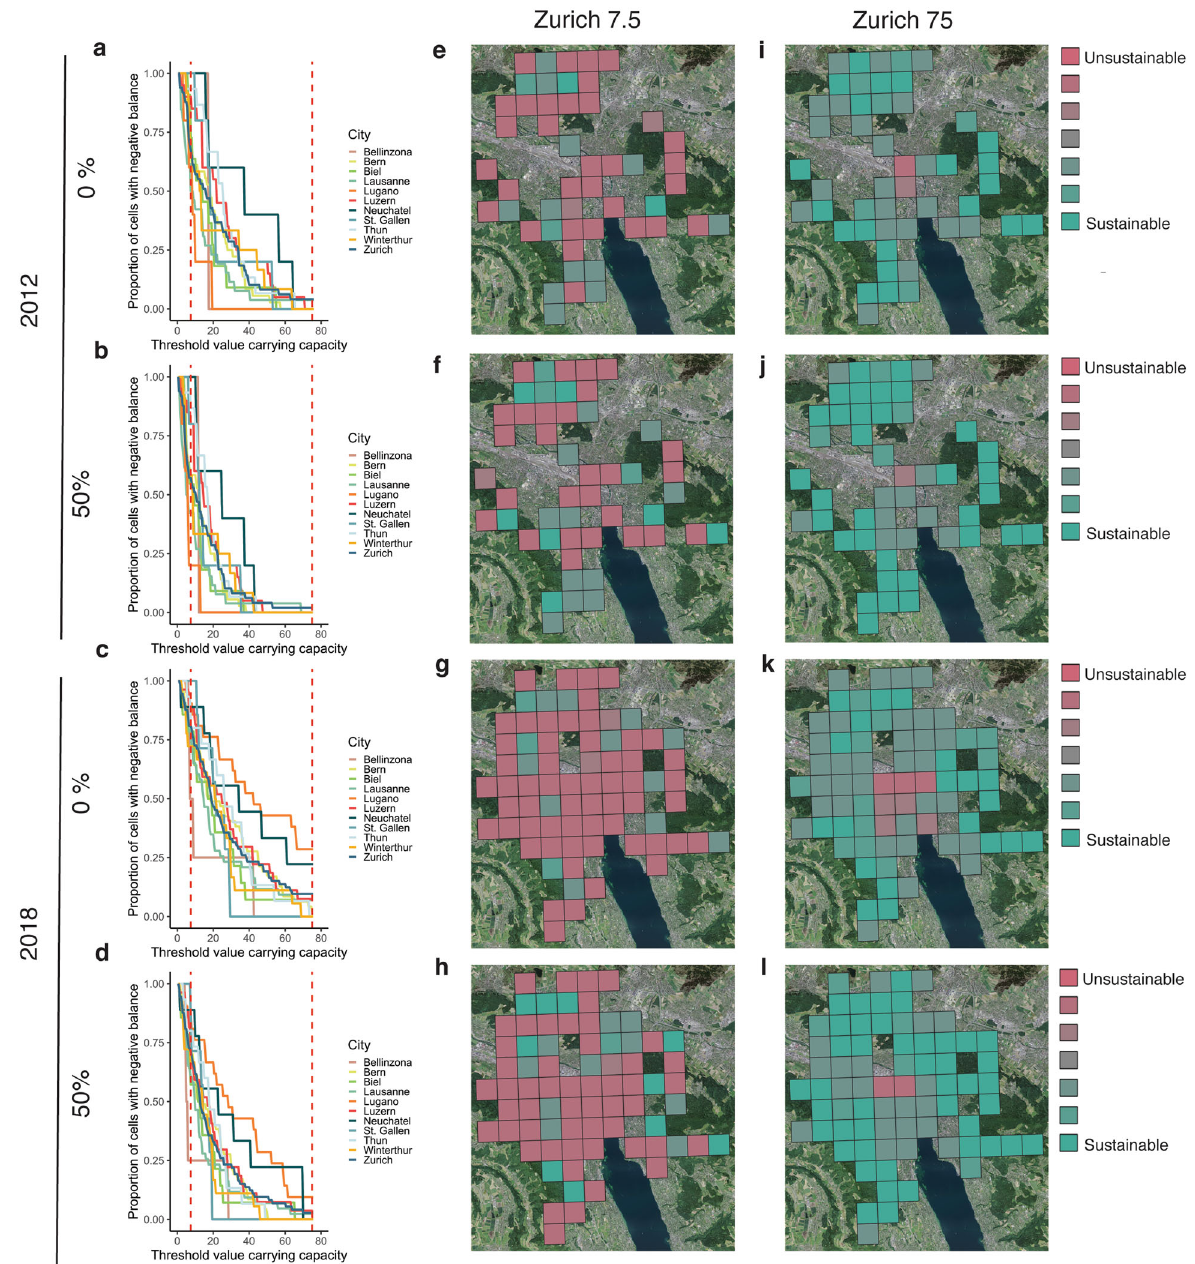
Fig. 2 Sustainability of urban beekeeping under different scenarios regarding the amount of available urban green space (UGS) and the carrying capacity for the years 2012 and 2018. a – d The proportion of cells with a negative UGS balance (Y-axis) (i.e. the available UGS is smaller than the required UGS based on the existing number of hives in the cell) for different carrying capacity values ( X -axis) for all cities in 2012 ( a and b ) and 2018 ( c and d ), and considering a 0% ( a and c ) or 50% ( b and d ) increase in available UGS. Each coloured line represents the model for one city. Dashed red vertical lines indicate the carrying capacities used in the plots ( e – l ) and represent 7.5 and 75 hives per 1 km 2 . e – l An example of the spatial distribution of the UGS balance in the cells in the city of Zurich for 2012 ( e , f , i , j ) and 2018 ( g , h , k , l ) considering an increase in both available UGS, from 0% ( e , g , i , k ) to 100% ( f , h , j , l ), and carrying capacity, from 7.5 ( e – h ) to 75 ( i – l ) hives per km 2 . See Supplementary Figs. 3 and 4 for additional scenarios, Supplementary Fig. 5 for the maps for all cities and Supplementary Fig. 6 for additional information on the balances in the UGS. Data supporting this fi gure can be found in Supplementary Data 2. Orthophotos from Zurich were obtained from the SWISSIMAGE 25 from the Federal Of fi ce of Topography Swisstopo openly accessible 30 Adding hives in new and existing beekeeping locations might result in strong pressure on available resources. In agricultural beehives was found to be negatively related to wild pollinator contexts, uncontrolled increases of other livestock have led to visitation rates 10 , yet in Perth, where honeybees are not native, what is known as a “ tragedy of the commons ” 12 , when an the effect of urban beekeeping on wild bees was mixed 7 . Cities are social-ecological systems, and individual decisions of stake- uncoordinated and unregulated exploitation results in the holders can have important impacts on the whole ecosystem. depletion of the common resources. The same applies to urban